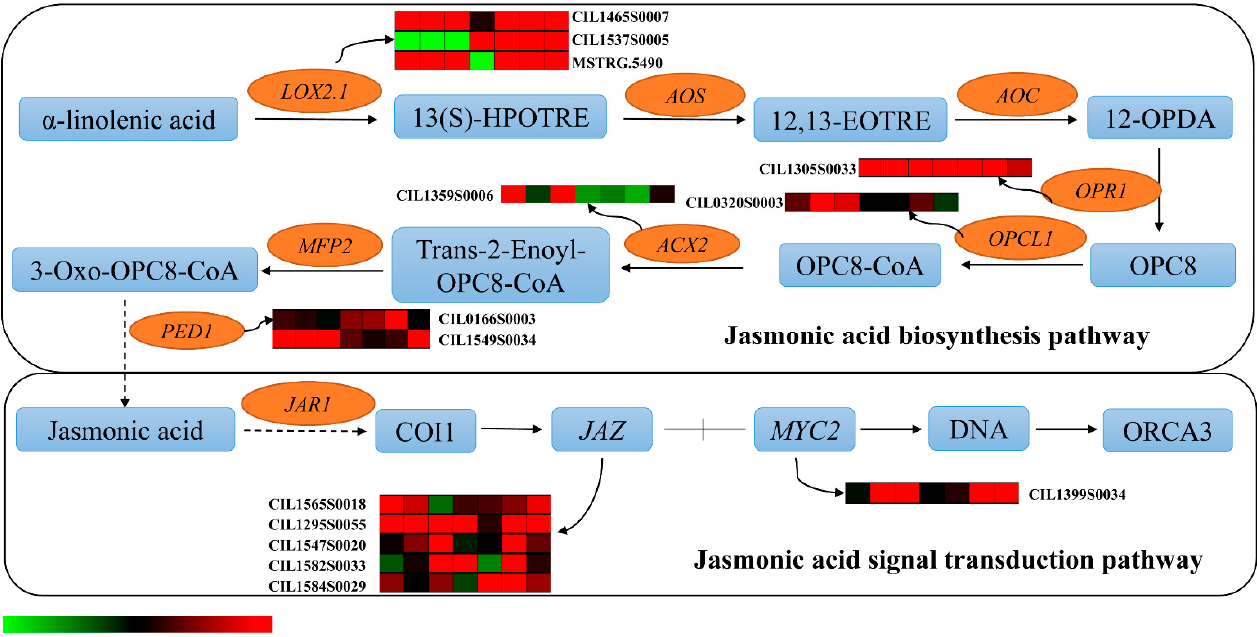
Figure 9. DEGs involved in jasmonic acid (JA) biosynthesis and signal transduction pathways. Responsive progression of genes expressions under different samples infection with PMV compared to CK, indicated in 7-box strings (including Y1-vs.-CK, Y2-vs.-CK, Y3-vs.-CK, G1-vs.-CK, G2-vs.-CK, G3-vs.-CK, ML-vs.-CK). Heat maps were drawn using log2 (transformed FPKM value of PMV infection/those of CK). Detailed gene and expression data are provided in Tables S15 and S17, available as Supplementary Data online. LOX, lipoxygenase; AOS, allene oxide synthase; AOC, allene oxide cyclase; ACX, acyl-CoA oxidase; PED1, 3-ketoacyl-CoA thiolase 2, peroxisomal-like; JAR1, jasmonate resistant 1; OPR, 12-oxophytodienoic acid reductase gene; OPCL1, OPC-8,0 CoA ligase gene; 13(S)-HPOTRE, (9Z,11E,15Z)-(13S)-13-Hydroperoxyoctadeca-9, 11,15-trienoic acid; 12,13(S)-EOTRE, (9Z,15Z)-(13S)-12,13-Epoxyoctadeca-9,11,15-trienoic acid; 12-OPDA, (15Z)-12-Oxophyto-10,15-dienoic acid; OPC8, 8-[(1R,2R)-3-Oxo-2-(Z)-pent-2-enyl cyclopentyl]octanoate; MYC2, transcription factor MYC2; JAZ, jasmonate ZIM domain-containing protein. The heat maps indicated the upregulation (red) and downregulation (green) of genes in PMV-infected samples compared to CK.